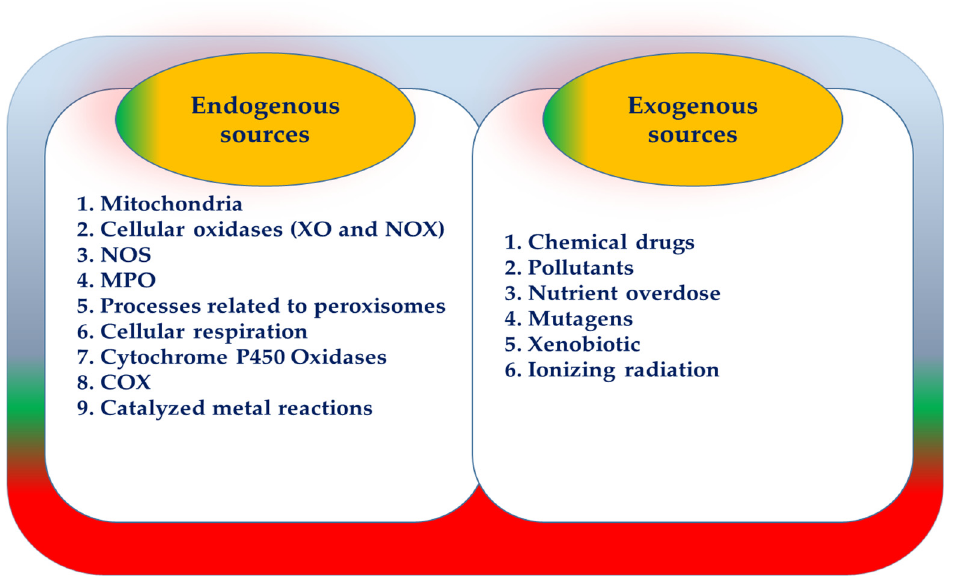
Figure 1. Reactive oxygen species (ROS) resources